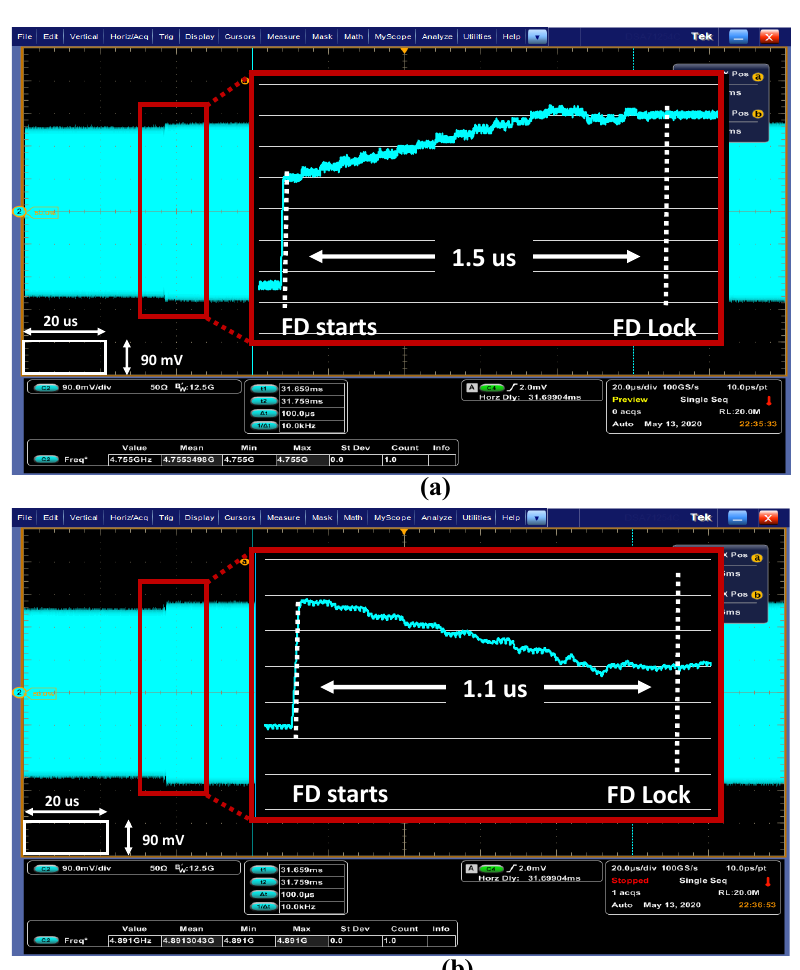
Figure 15. The measurement results of frequency locking behavior at 10 Gb/s: ( a ) Incremental search ( b ) Decremental search.